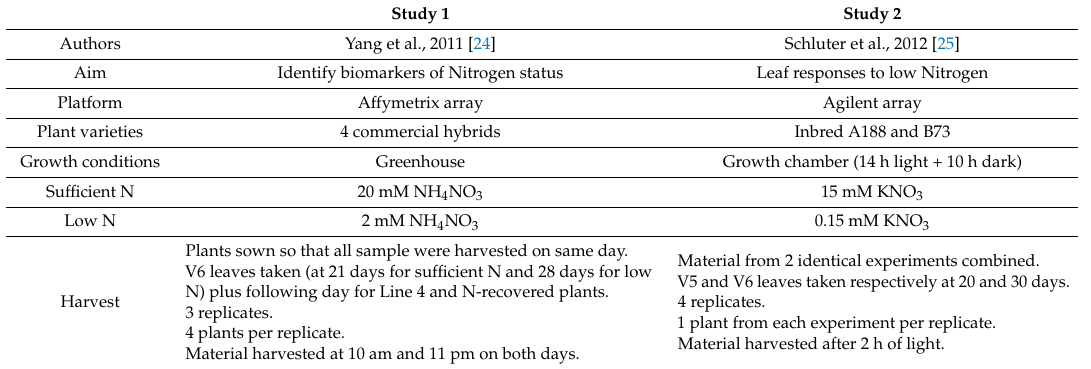
Table 1. Details of two maize microarray